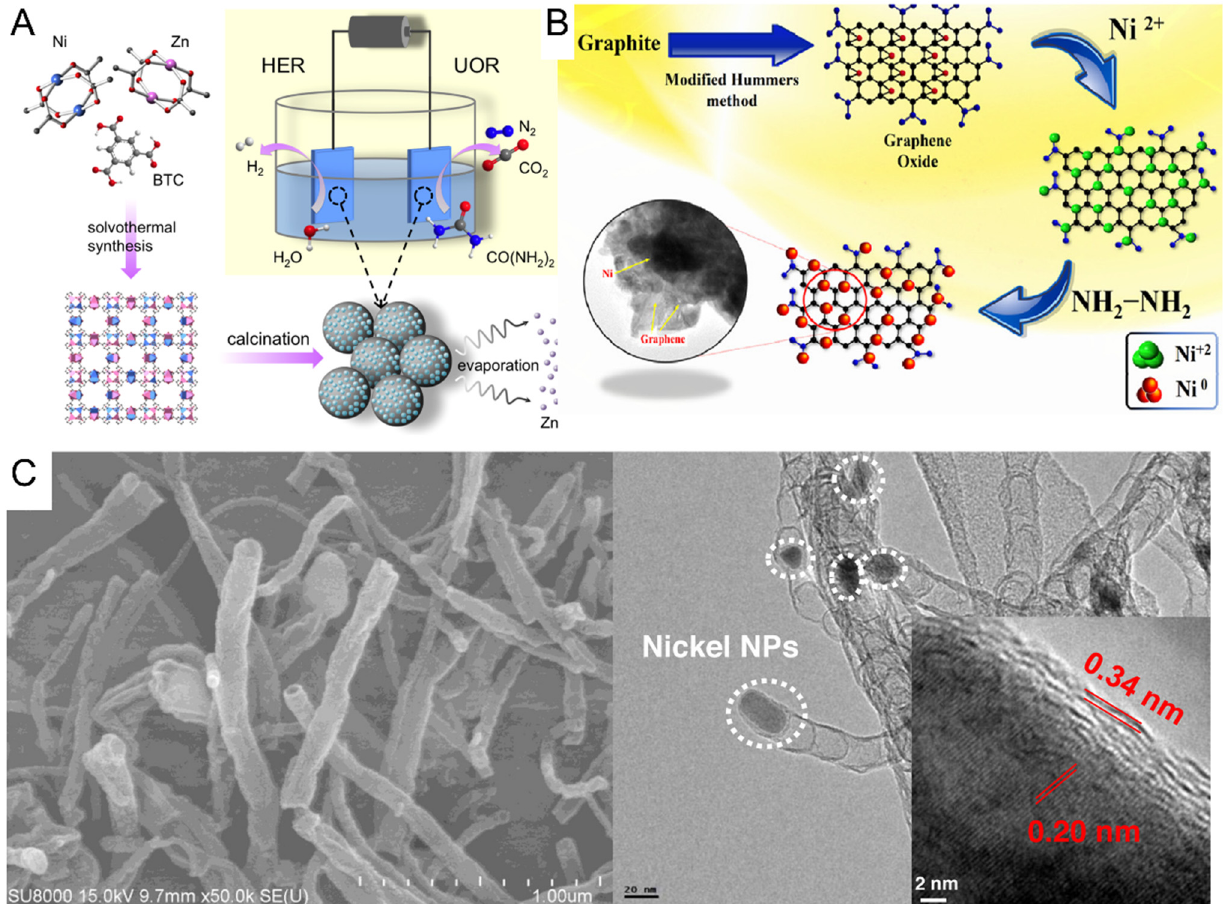
Figure 9. ( A ) Schematic representation of the synthesis and bifunctionality of Ni/C composite [117]. Reproduced with permission [117]. Copyright 2018, American Chemical Society. ( B ) SEM, TEM, and